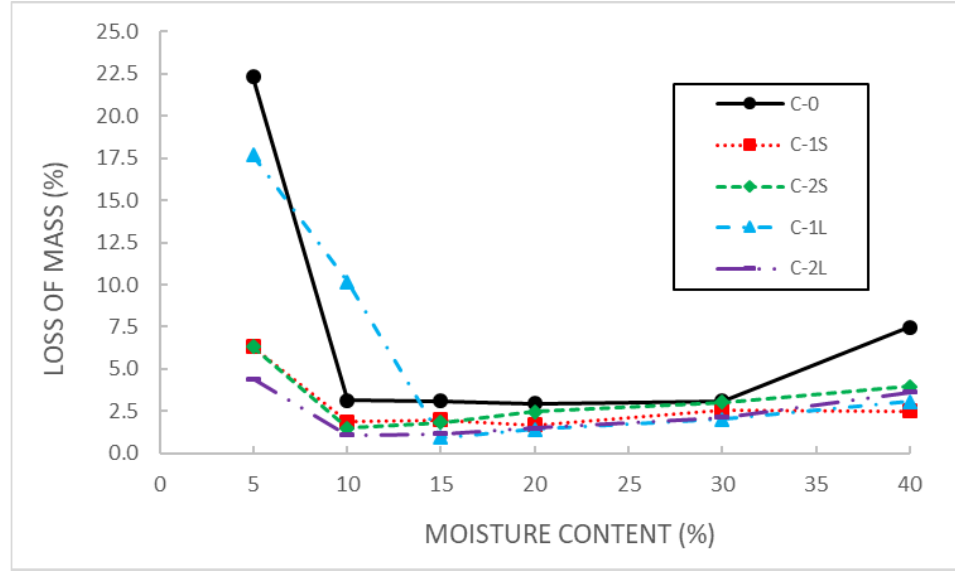
Figure 4. Loss of mass of the mechanical durability test.